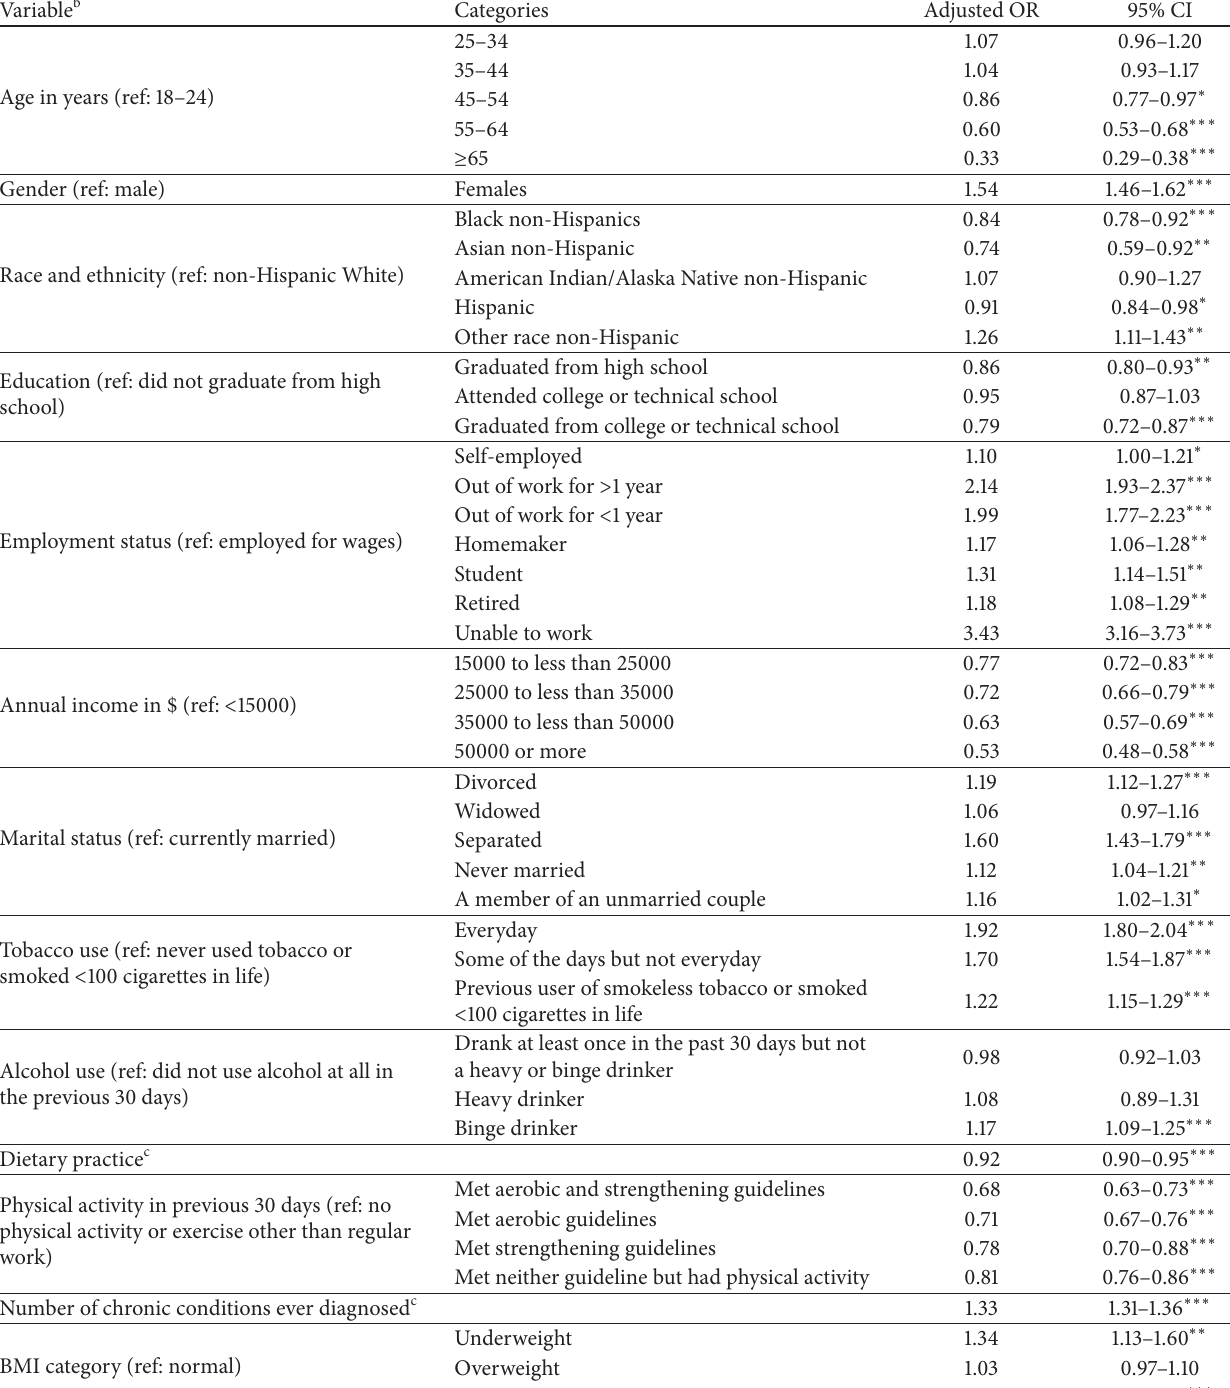
Table 4: Adjusted odds ratios a of having FMD among adults in the United States, BRFSS 2011 ( 𝑁 = 380637